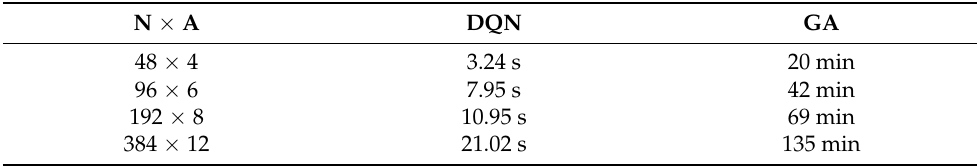
Table 5. Comparison of the computational efficiency.